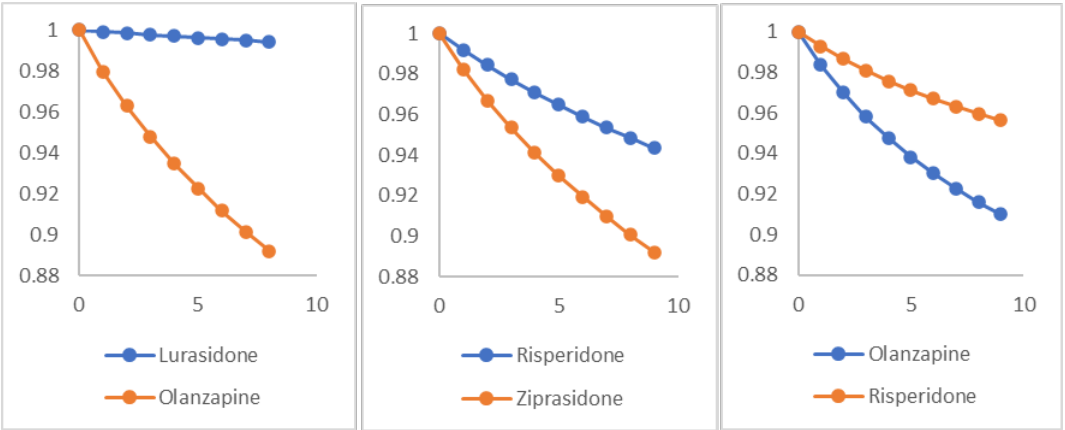
Figure 3. Examples of survival curves for three paired drugs on the outcome of SREs. X axis is months of follow up and y axis is the survival rate. These curves were generated by adjusting the baseline and post-baseline variables and may not reflect the real data. SREs: suicide-related events.